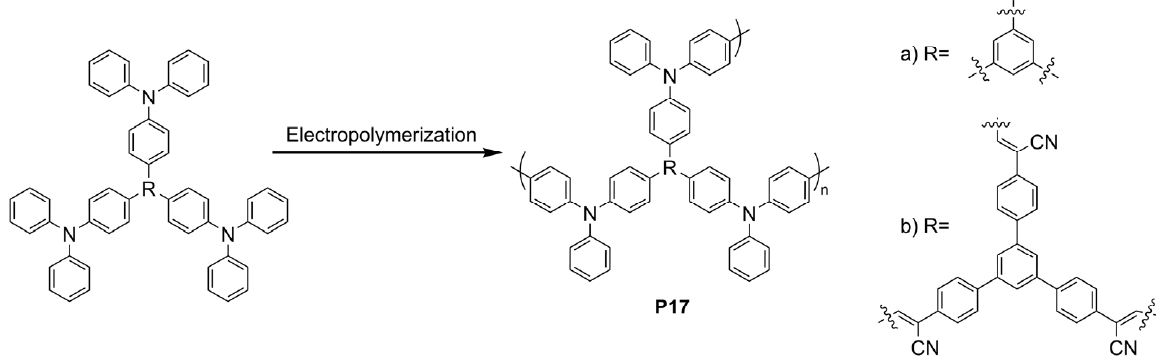
Figure 17. EFC polymer prepared by anodic electropolymerization [166].